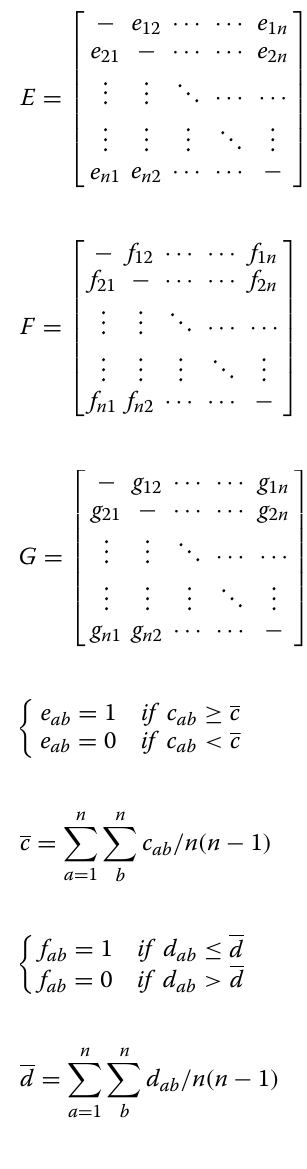
Equations (52)–(59) demonstrate the concordance E , discordance F and aggregated G index